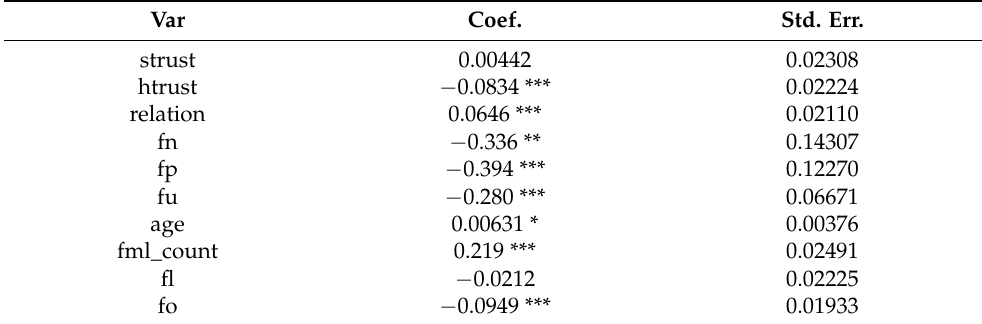
Table 5. Regression results of the Logit model. Var Coef. Std. Err. strust 0.00442 0.02308 htrust − 0.0834 *** 0.02224 relation 0.0646 *** 0.02110 fn − 0.336